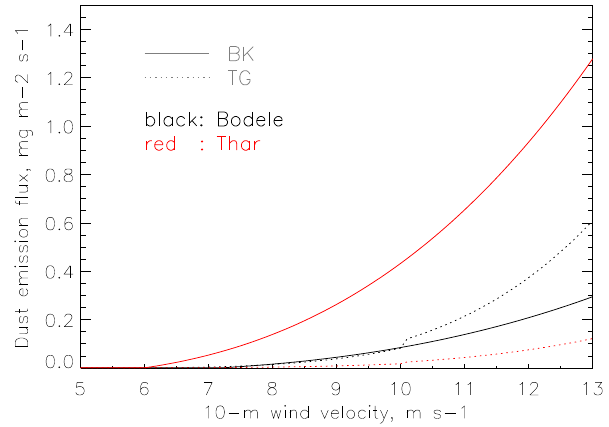
Fig. 1. Vertical dust emission flux (mgm − 2 s − 1 ) vs. 10-m wind ve- locity (m s − 1 ) as simulated with the two dust emission schemes by Balkanski et al. (2004) (solid lines) and Tegen et al. (2002) (dotted lines) in the Bod´el´e Depression (black) and the Thar Desert